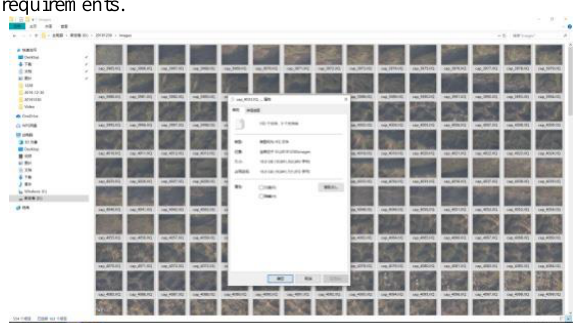
Figure 8. Route design